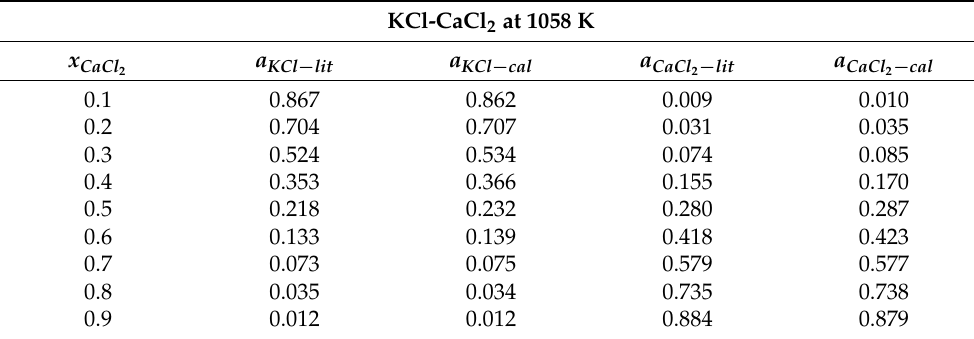
Figure 12. Comparison of the calculated activities and literature data of each element of the KCl ‐ CaCl 2 system (1058 K).